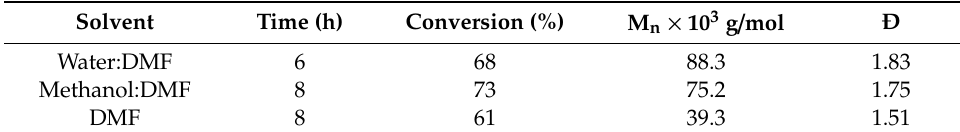
Table 1. Polymerization of 2-acrylamido-2-methyl-1-propanesulfonic acid (AMPS) mediated by